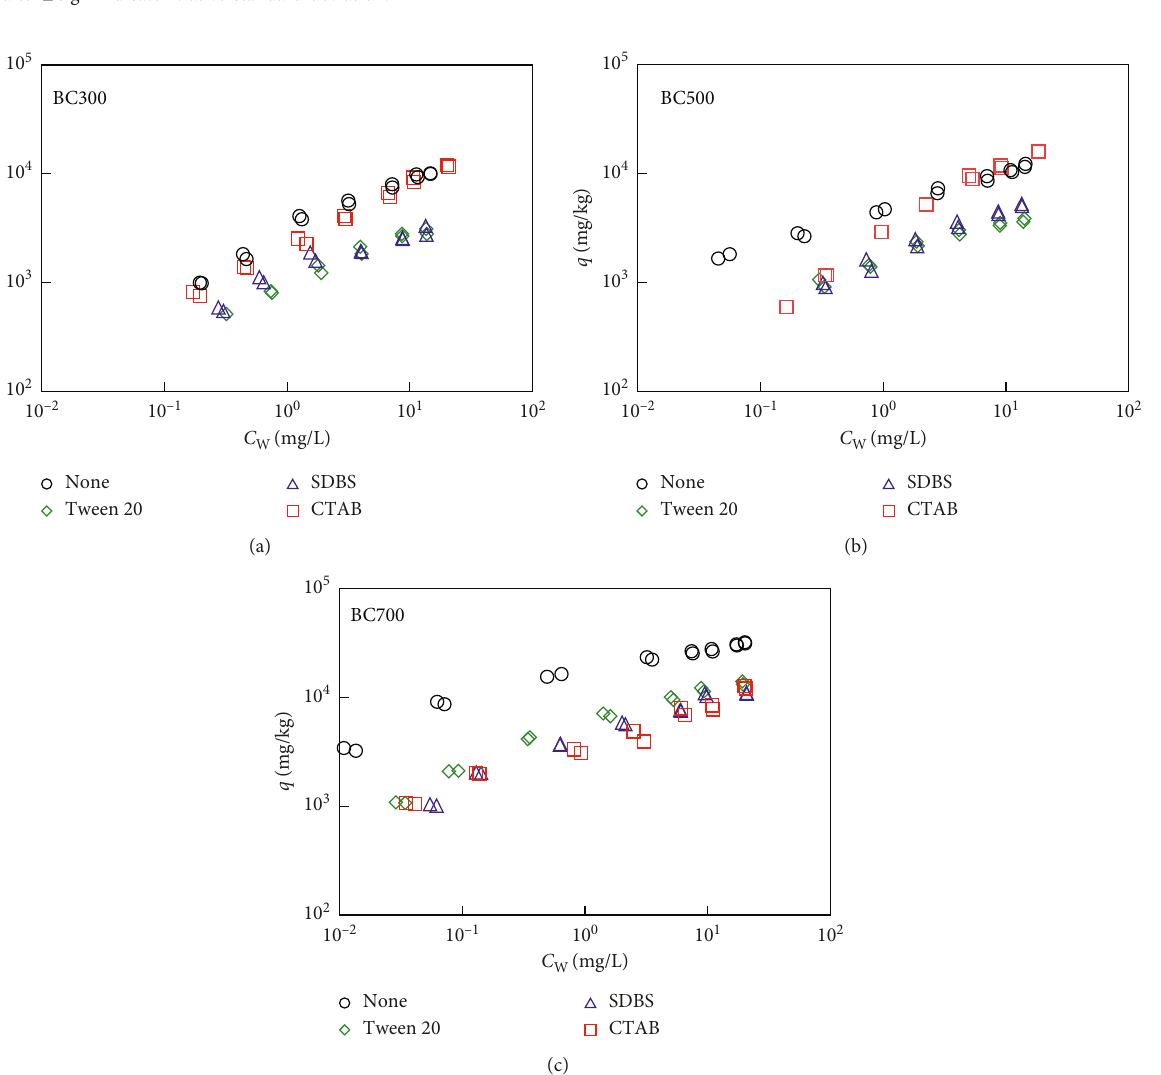
Figure 6: Adsorption isotherms of BPA to BC300, BC500, and BC700 in absence and presence of the